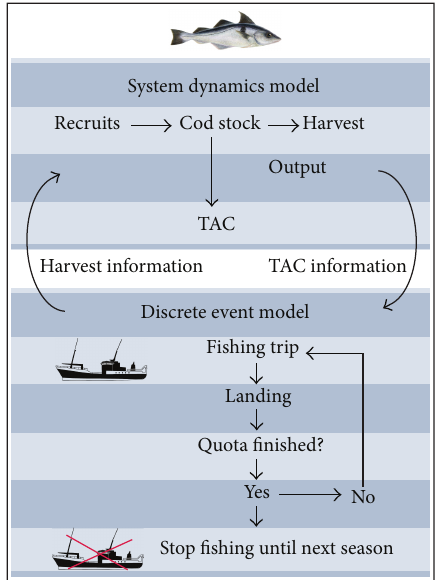
Figure 3: A diagram describing the hybrid-simulation model and the interaction between the SD model and the DE model.